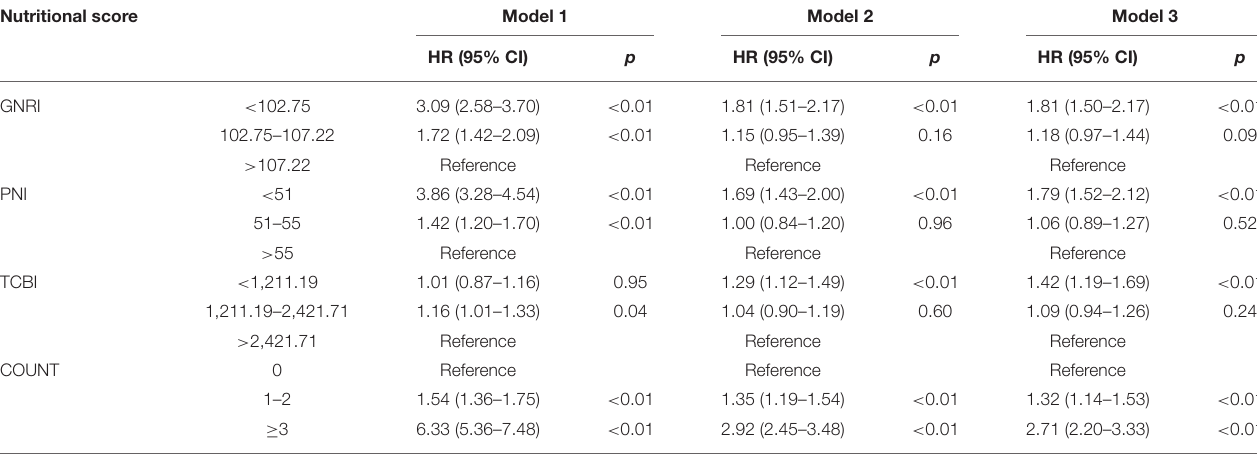
TABLE 2 | Cox regression analysis of nutritional scores with all-cause mortality. Nutritional score